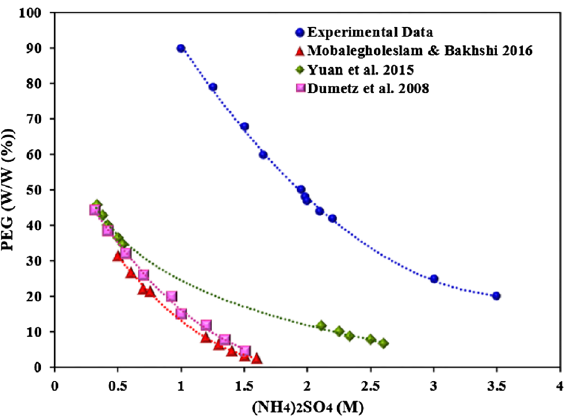
Figure 4. Comparison of the phase diagram of (NH 4 ) 2 SO 4 -polyethylene glycol (PEG) system with the previous data in the literature.